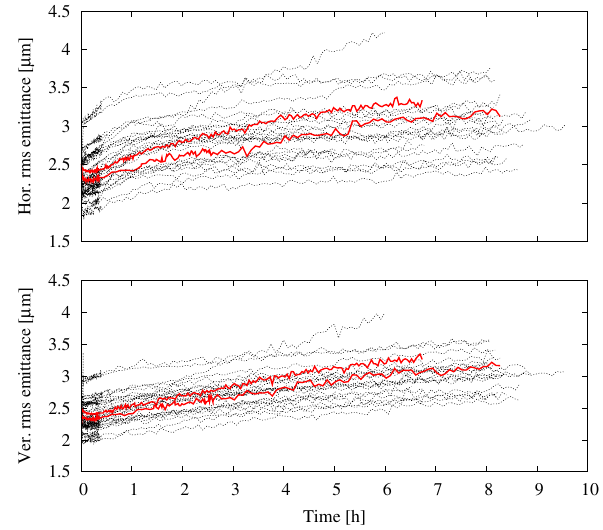
FIG. 20. Horizontal (top) and vertical (bottom) rms emittance of 30 stores. The two red marked stores had the Yellow electron lens on for 6.75 h and 5.28 h respectively, for all other stores the lenses were on between 0.45 to 1.83